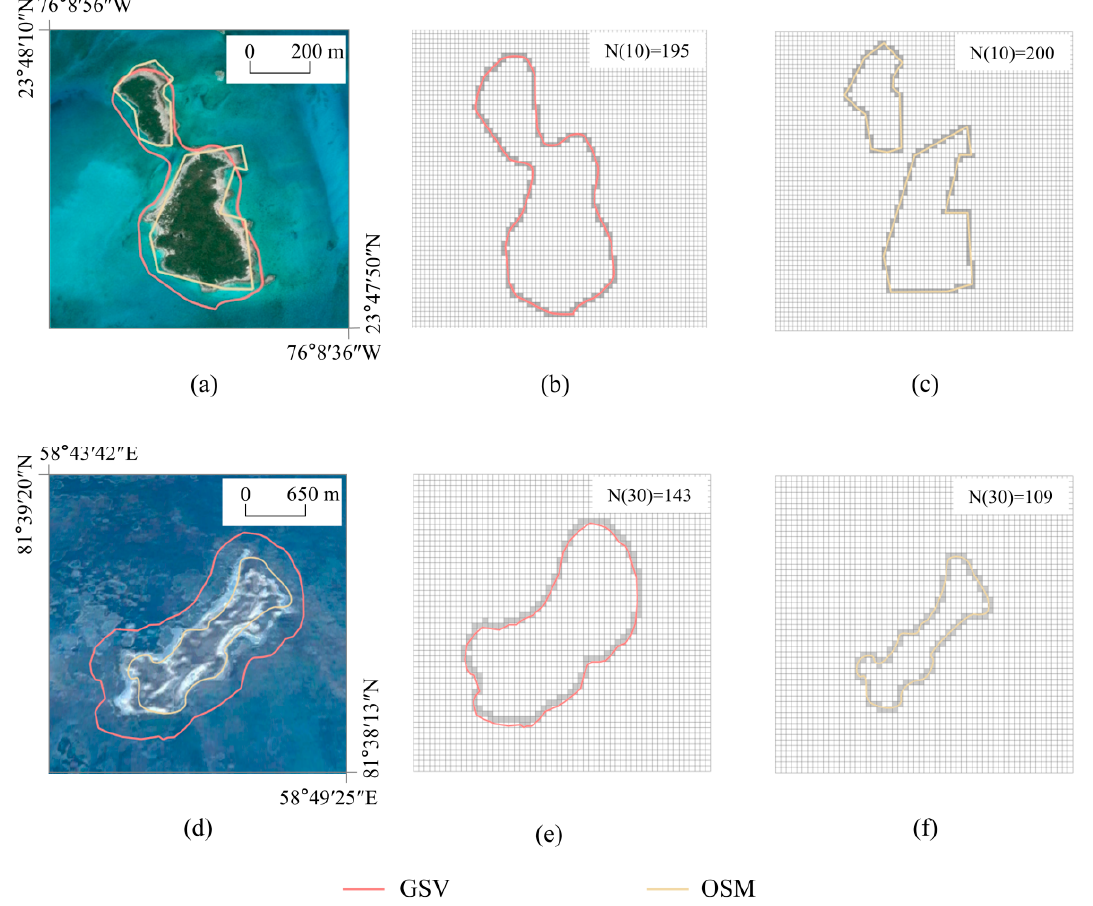
Figure 10. Two examples ( a – c and d – f ) are used to understand the results in Figure 9. For each example, both datasets are superimposed on either a Google satellite image or a regular grid.